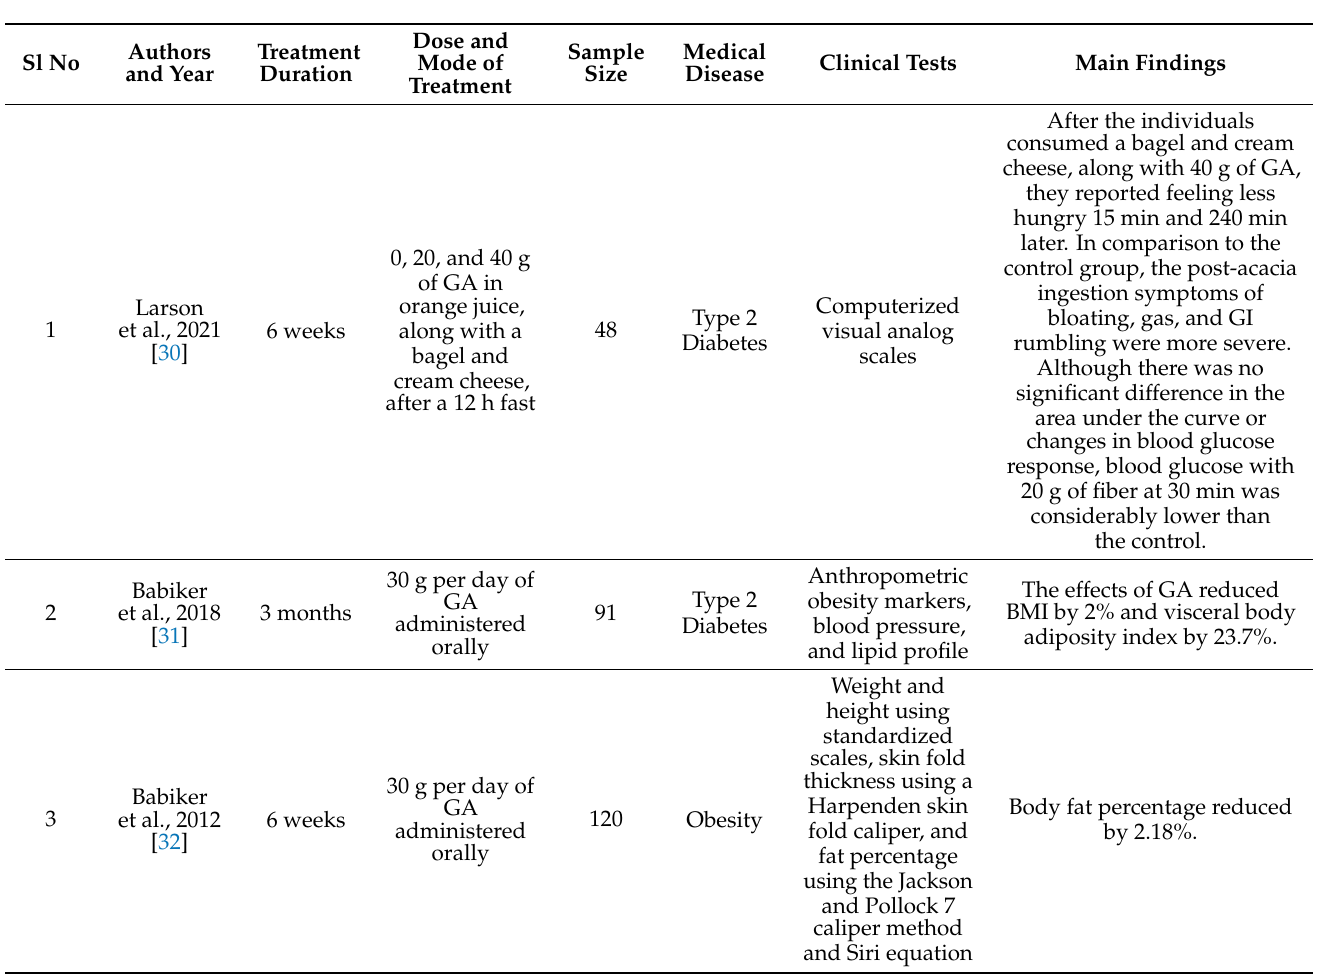
Table 1. Table showing the study characteristics of clinical trials conducted to show the beneficial effects of GA in various medical